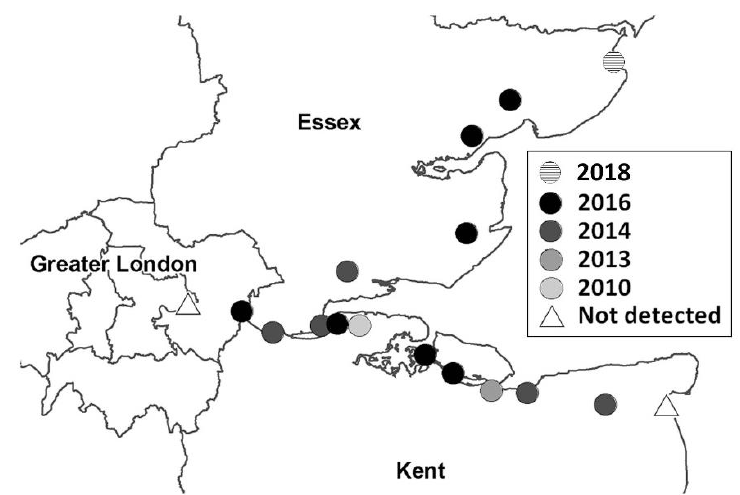
Figure 3. Distribution of Culex modestus mosquito in the Thames Estuary, up to July 2018.